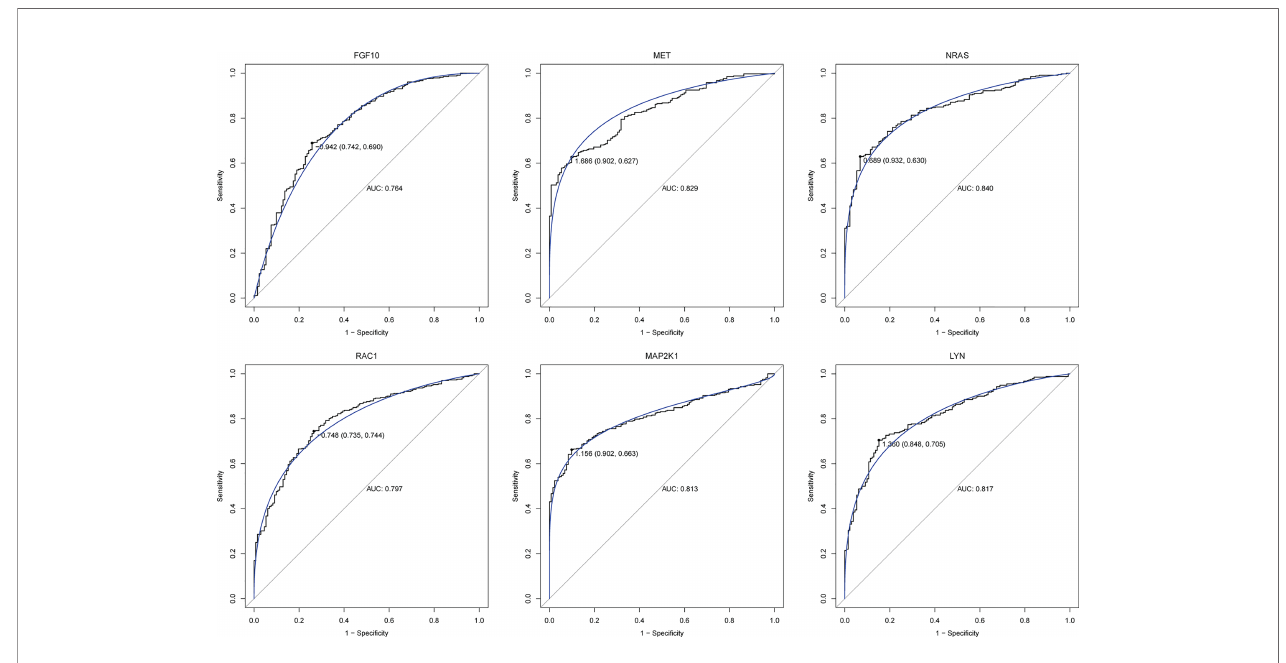
FIGURE 7 | ROC analysis of six core immune-related mRNAs in the PPI network in GC.